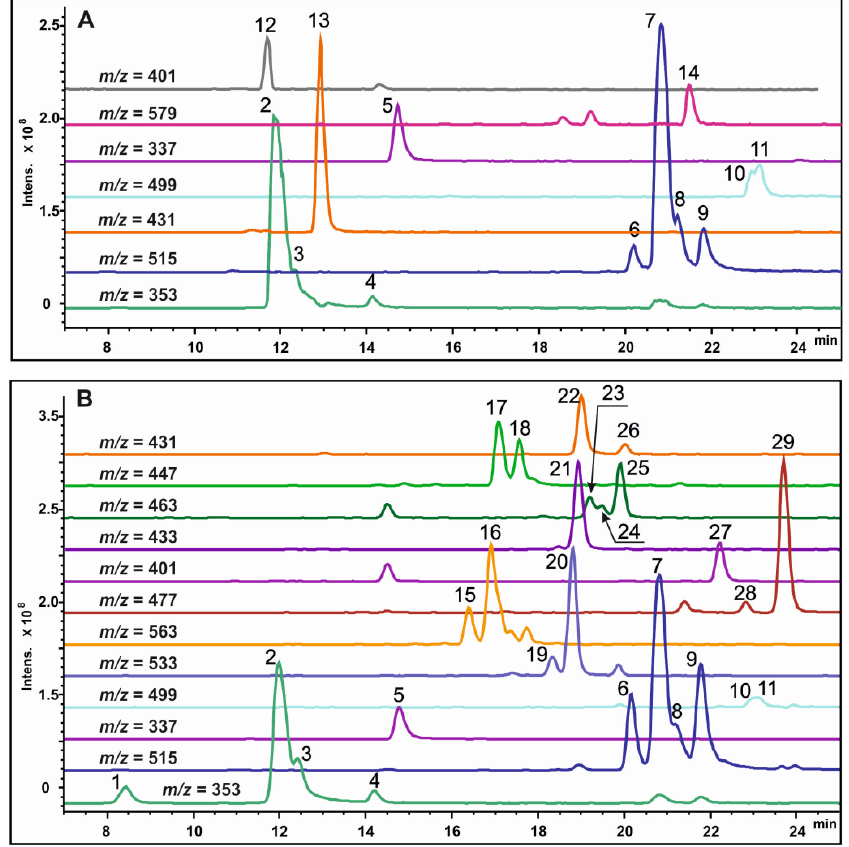
Figure 3. The HPLC-ESI-MS analysis of extracts obtained from the Sr-L1 callus line ( A ) and leaves ( B ) of S. radiata . Extracted ion chromatograms of the identified components in negative ion detection mode are presented. The monitored ions correspond to the most abundant deprotonated molecules [M-H] − for 1 – 11 and 14 – 29 , and acetylated molecular ions [M+CH 3 COO] − for 12 and 13 . Peak numbers correspond to each of the identified components listed in Tables 1 – 4.